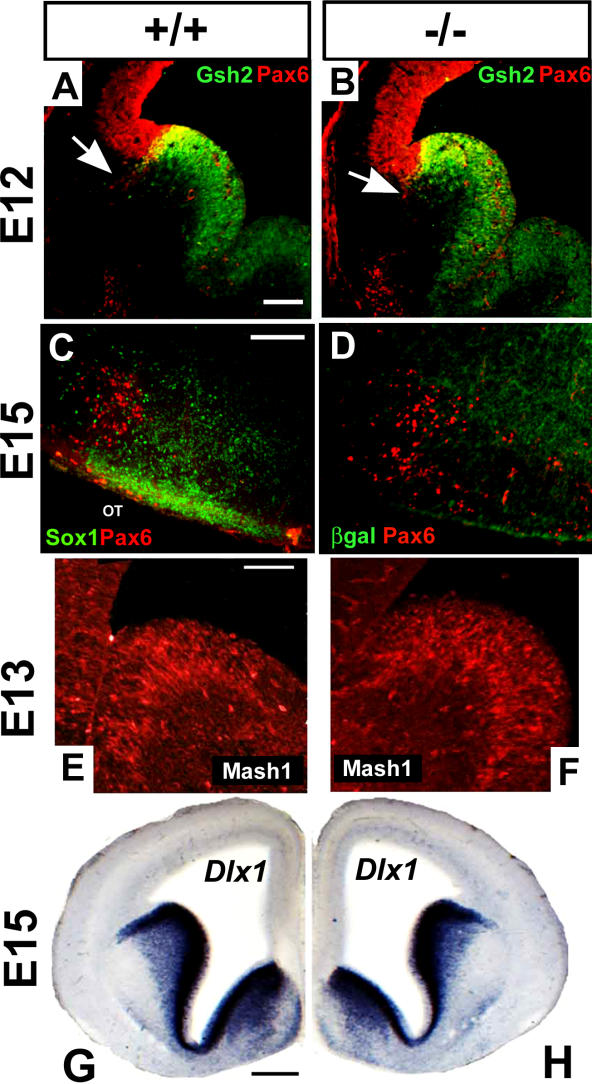
Normal Generation and Patterning of LGE Precursors in the Absence of SOX1(A and B) Immunocytochemistry and on coronal brain sections of dorsal and ventral telencephalic markers in wild-type (+/+) and Sox1-null (−/−) embryos. PAX6 and GSH2 immunocytochemistry in the dorsal LGE at E12 shows no difference at the expression boundary in the absence of SOX1; the arrows point at the stream of PAX6-positive cells emanating from the boundary.Double immunostaining for SOX1/PAX6 in wild-type brain (C), and for β-galactosidase/PAX6 (D) in the Sox1
βgeo/− brain, at the VS area at E15. Note the presence of the PAX6-positive neurons in the area of the VS in the Sox1
βgeo/− brain.(E and F) MASH1 immunocytochemistry in the LGE of wild-type (E) and Sox1-null brain (F), at E13. No changes are detected.(G and H) The distribution of Dlx1-expressing cells, as detected by in situ hybridization, is similar in both wild-type and mutant brains.Scale bar = 300 μm (A and B), 200 μm (C–F), 150 μm (G and H).